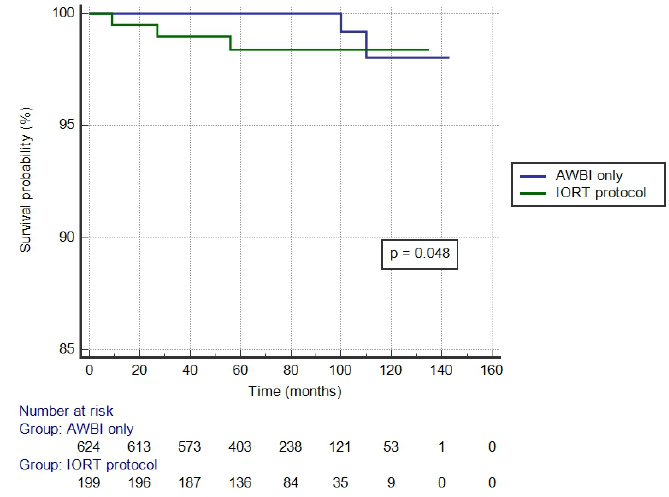
Figure 2. Locoregional relapse-free survival in the analyzed group.